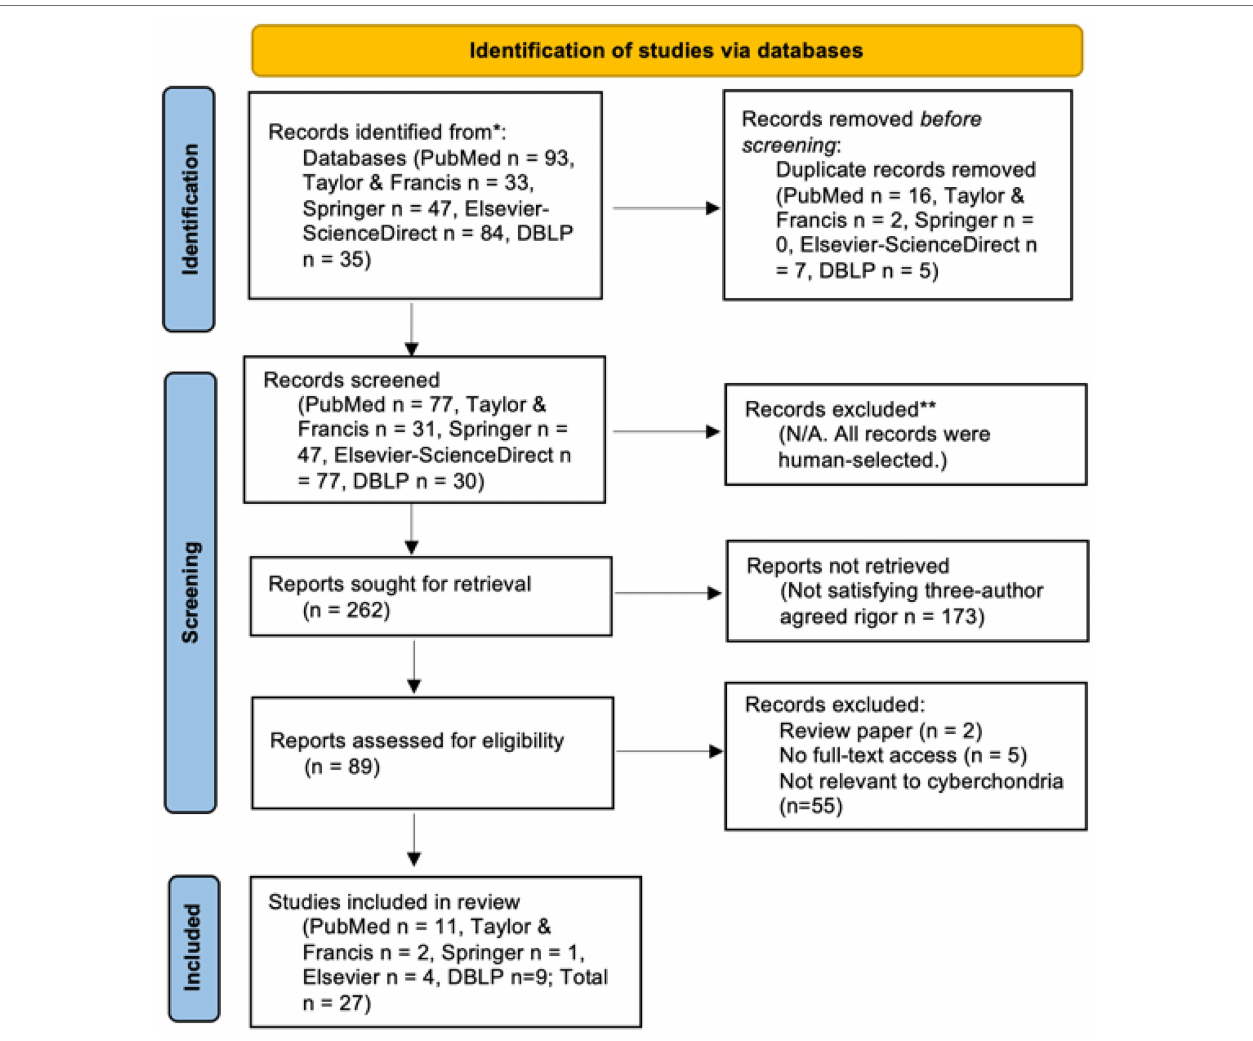
FIGURE 1 | The PRISMA flow diagram of the studies included in this